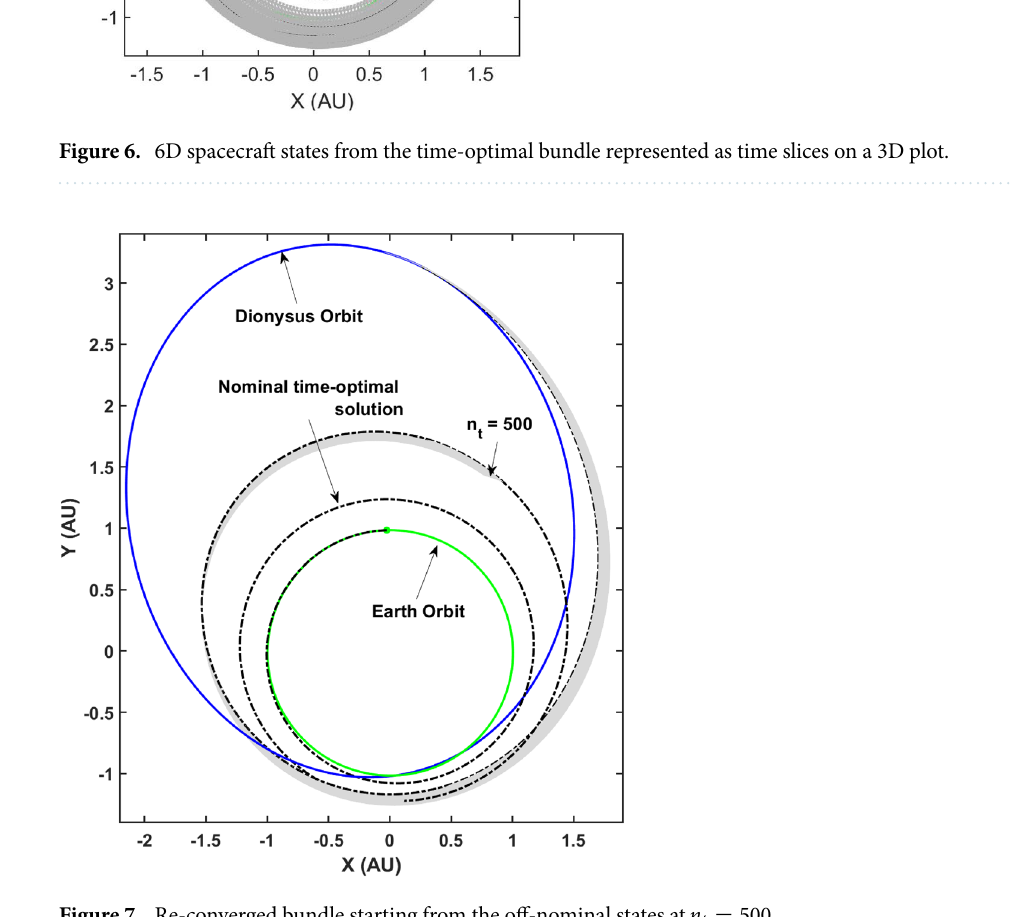
Figure 7. Re-converged bundle starting from the off-nominal states at n t